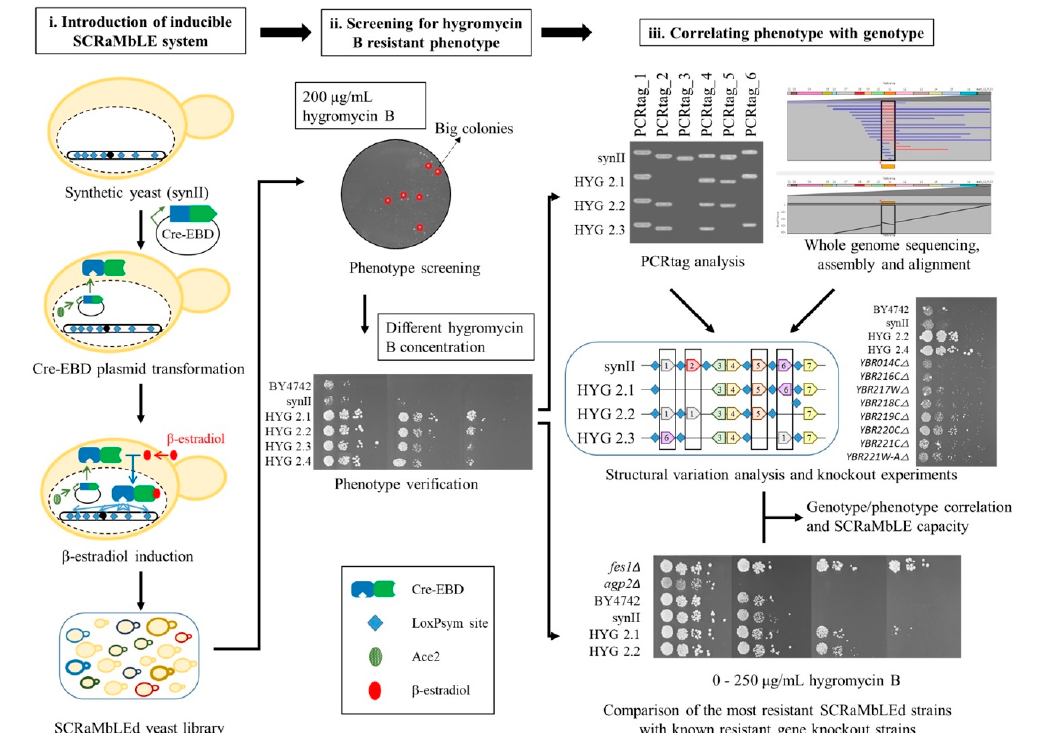
Figure 1. Schematics of a SCRaMbLE workflow to generate synthetic yeast with increased hygromycin B resistance. The